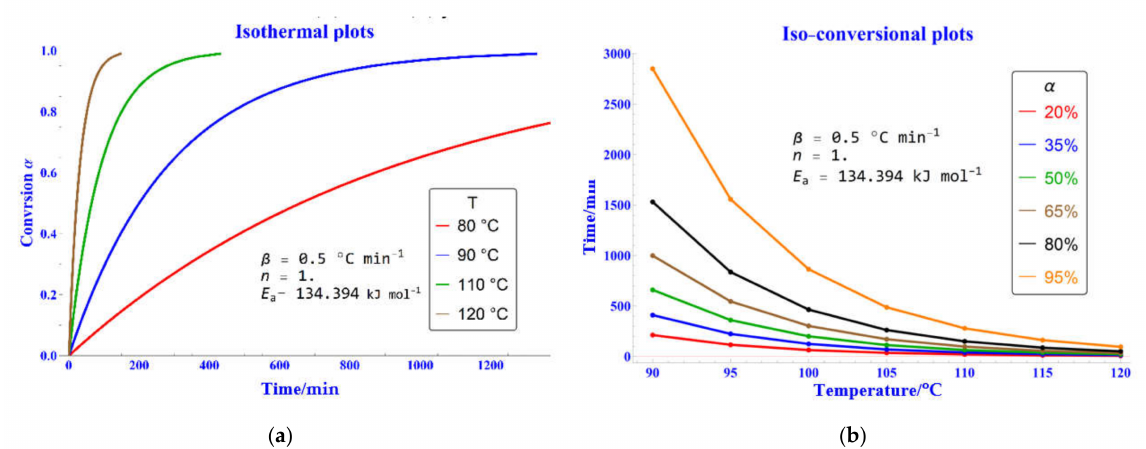
Figure 11. Application of rate constant k ( T ): ( a ) isothermal simulation result plots; ( b ) iso-conversional simulation result